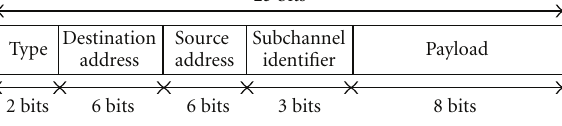
Figure 5: Best-e ff ort packet format SDM-based router.